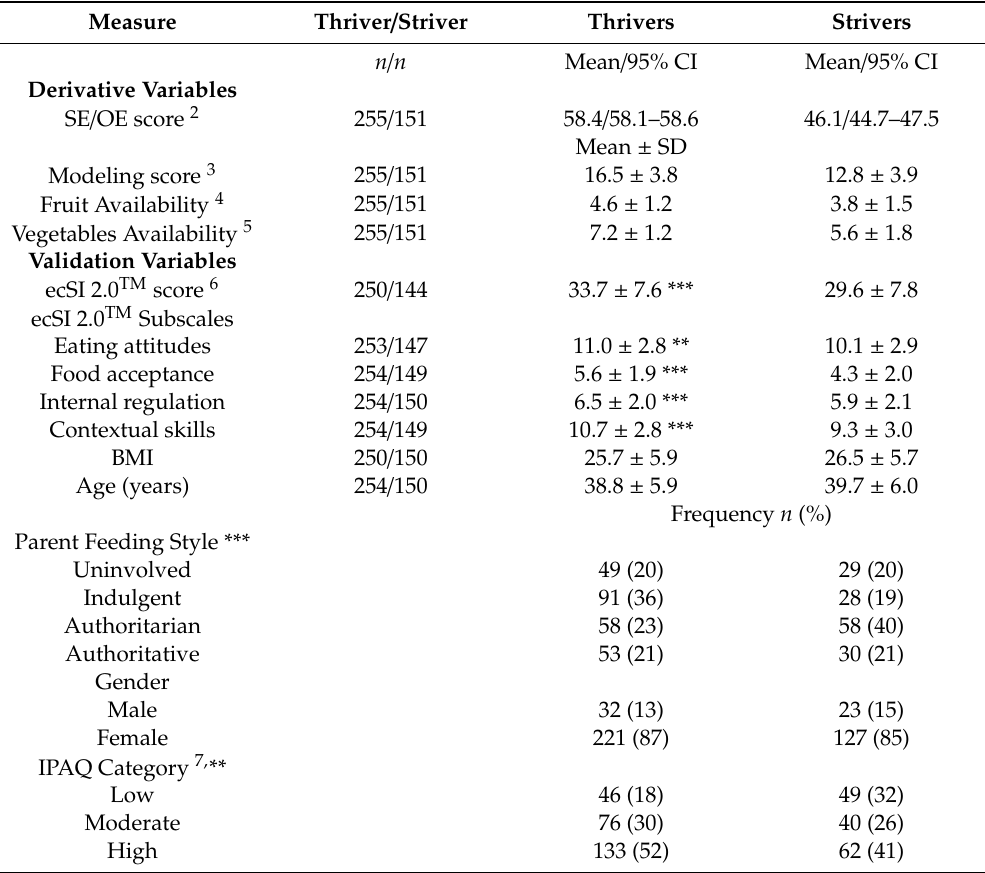
Table 4. Behaviors compared between parents in clusters of thriving or striving for healthful and competent feeding behaviors 1